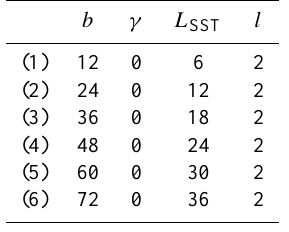
Table 4. Parameter combinations of the precipitations for SST. b : a time length of both past and future parts, γ : a start position of the subtime series in the future part from the reference time, L SST : a window length for these subtime series, l : the number of the left singular vectors of the past part to span a hyperplane.